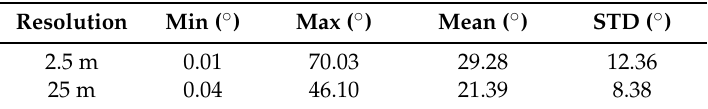
Table 1. Statistics of slope based on DEMs with resolution of 2.5 m and 25 m.